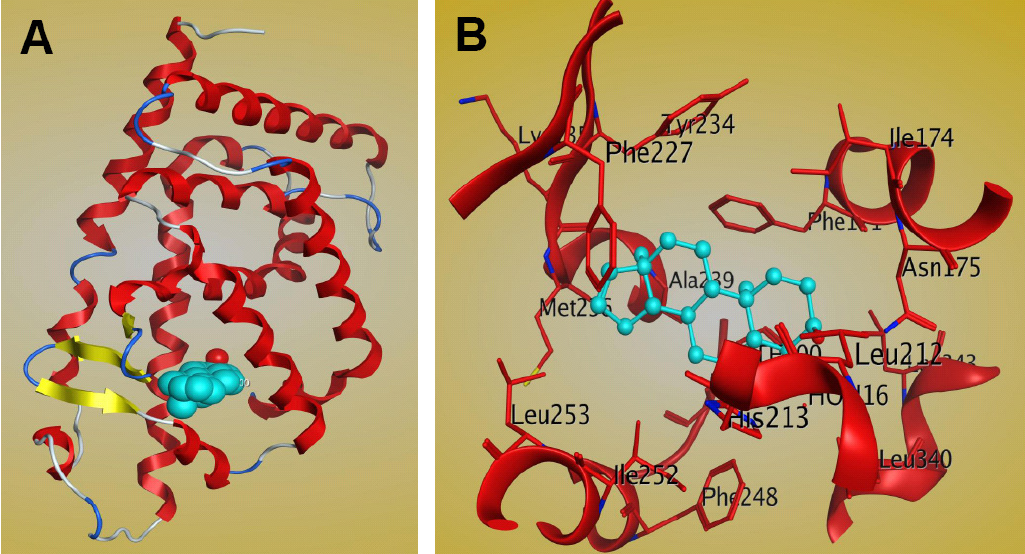
Figure 6. Structure of the mCAR LBD–androstenol complex (PDB: 1XNX). ( A ) Ribbon representation of one of the two CAR molecules in the asymmetric unit bound to the ligand androstenol (cyan). ( B ) Interactions between CAR and androstenol within the ligand binding pocket, as shown by MOE